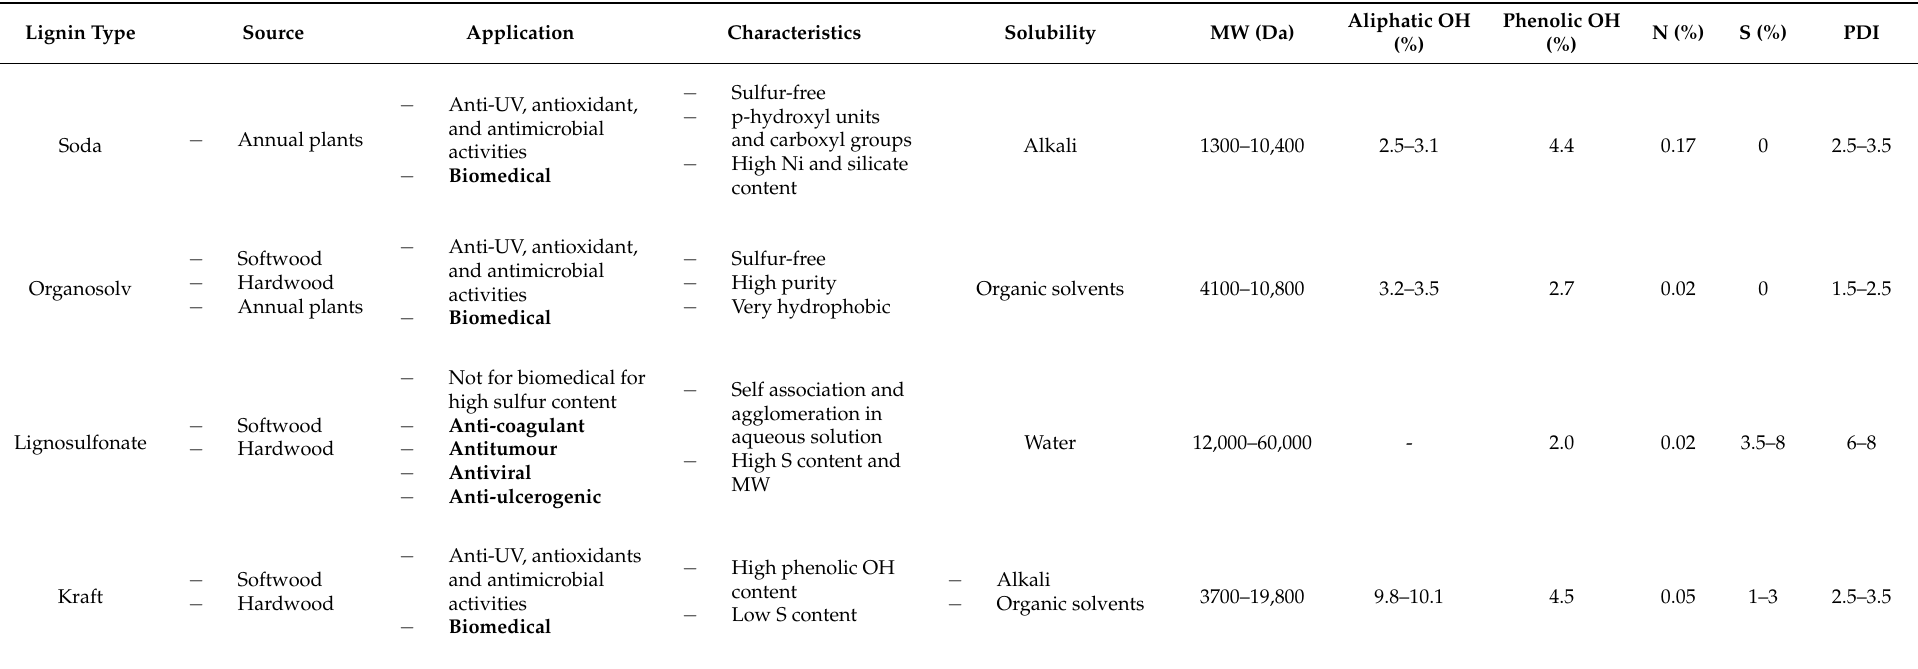
Table 3. Lignin type: characteristics and